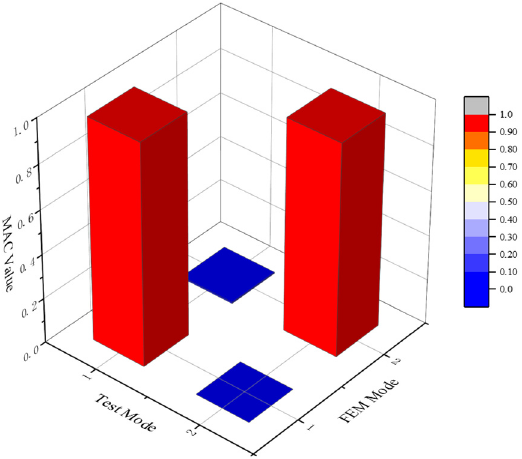
Figure 17. MAC value between test and FEM mode shapes.